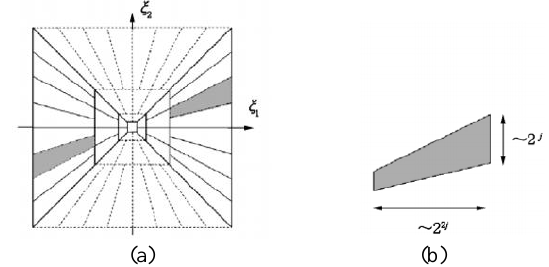
Fig 2. Spatial-frequency plane and frequency support of Shearlets: (a) Frequency domain split of Shearlet, (b) Frequency domain support of